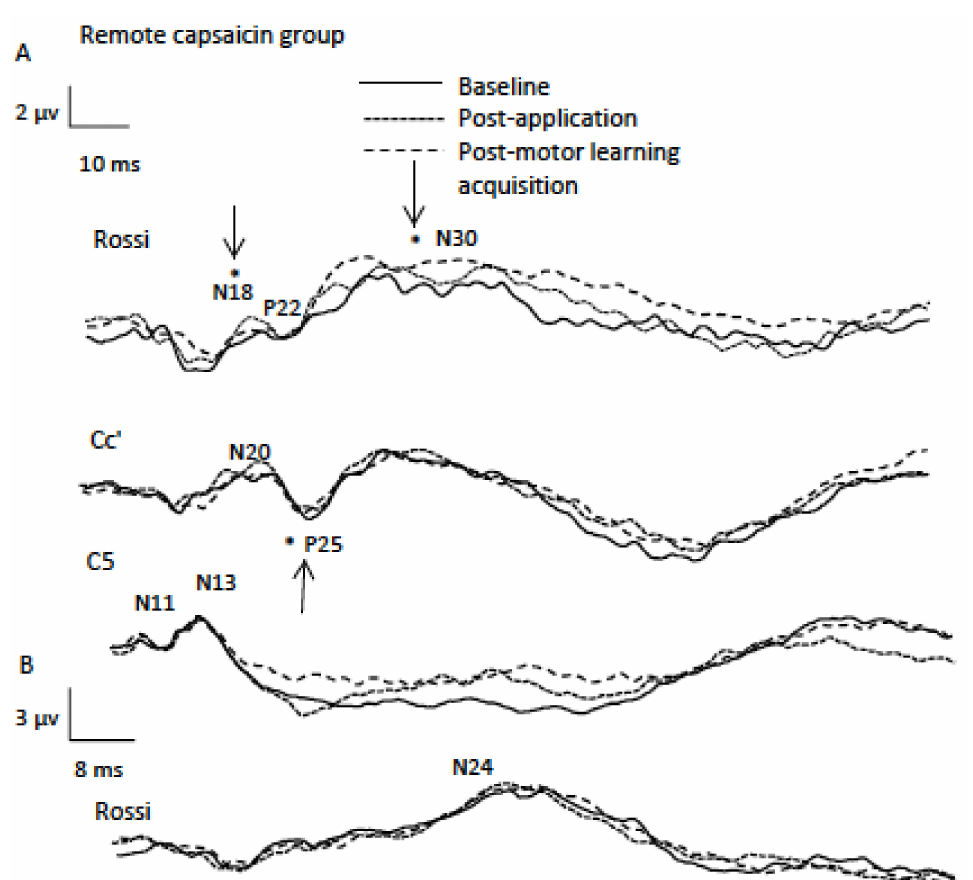
Figure 4. Data from a representational remote participant (average of 1000 traces) indicating SEP peaks including A (2.47 Hz) and B (4.98 Hz) sessions. Note the significant differences for the P25 SEP peak following capsaicin application and for the N18 and N30 SEP peaks following motor learning acquisition as indicated by